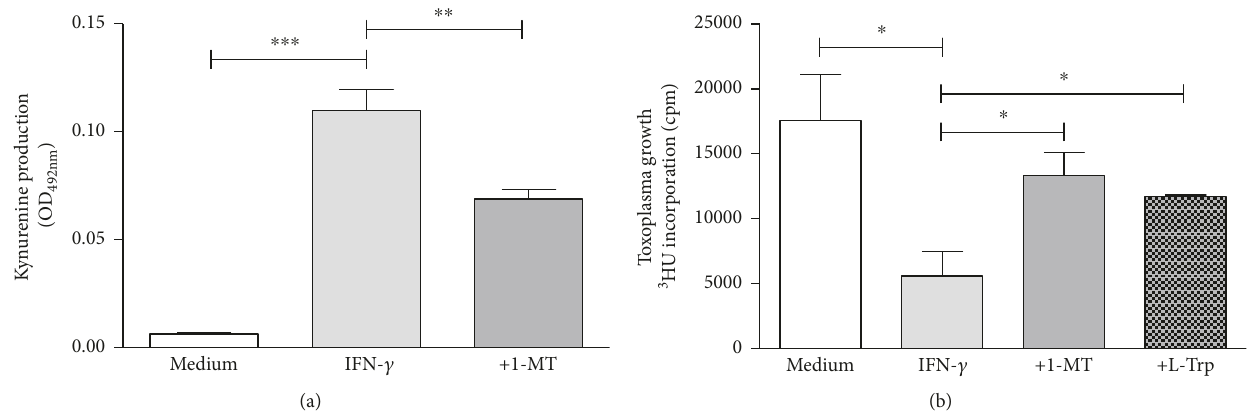
Figure 5: IFN- γ induces IDO activity and antiparasitic e ff ects in porcine PCP-R cells. 3 × 10 5 PCP-R cells were stimulated with IFN- γ (100ng/ml). In some groups, the IDO inhibitor 1-methyltryptophan (1-MT) was supplemented (100 μ g/ml). Kynurenine concentration was determined in the supernatants using Ehrlich ’ s reagent after three days of stimulation (a). Identical cell cultures were stimulated and afterwards infected with T. gondii (3 × 10 4 ME49 tachyzoites per well). In the control group, L-tryptophan (L-Trp) (100 μ g/ml) was added at the time of infection. After three days, toxoplasma growth was monitored using 3 H-uracil incorporation (b). Data are given as mean ± SD of triplicate cultures; signi fi cant di ff erences were marked with asterisks ( ∗ p ≤ 0 05 , ∗∗ p ≤ 0 01 , and ∗∗∗ p ≤ 0 0001